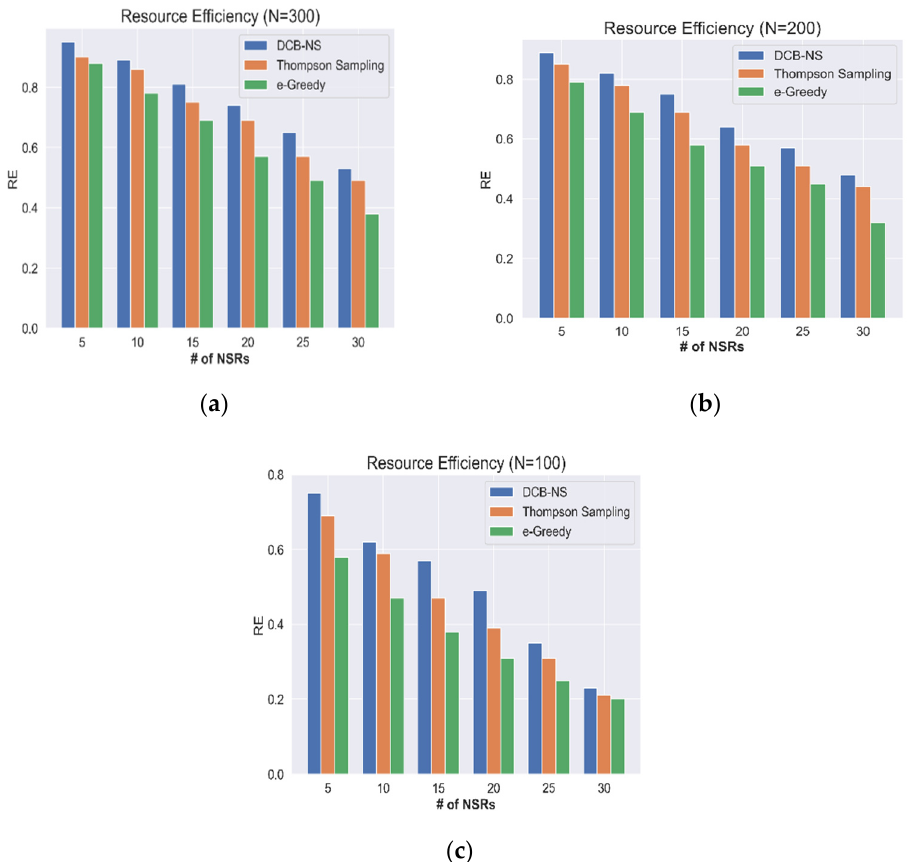
Figure 4. Network Resource Efficiency according to the maximum number of nodes: ( a ) N = 300, ( b ) N = 200, and ( c ) N = 100.